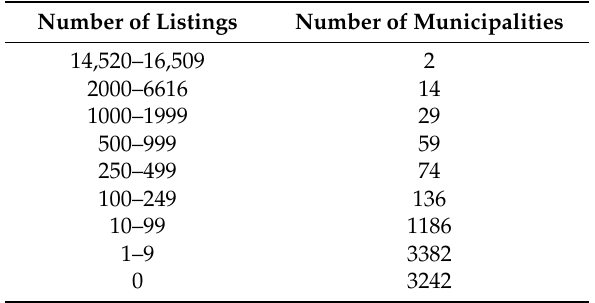
Table 2. Numbers of Airbnb listings in Spanish municipalities. Number of Listings Number of